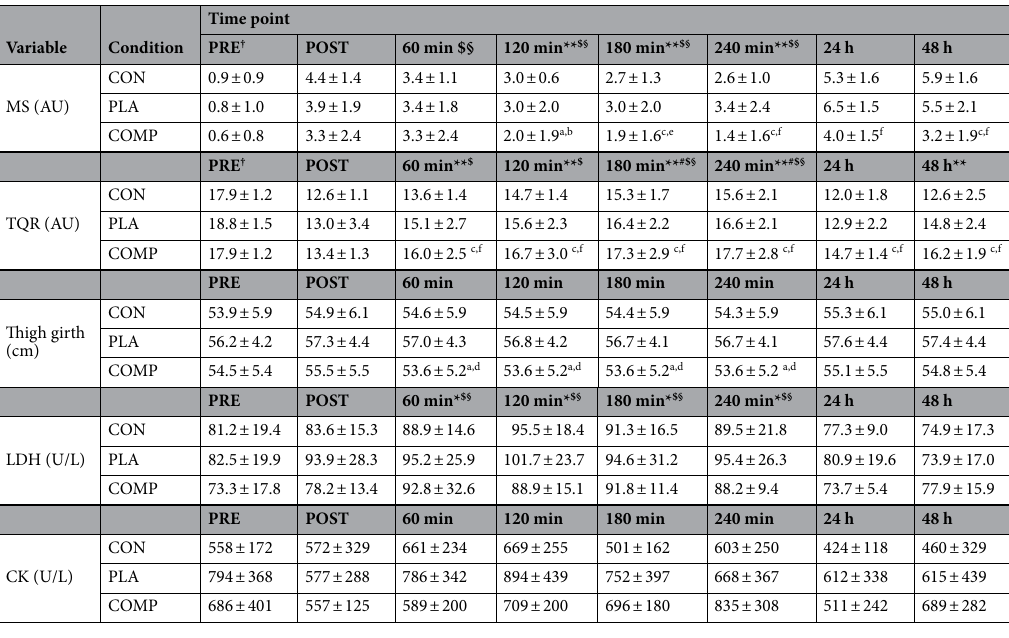
Table 5. Muscle soreness (MS), total quality of recovery (TQR), thigh girth, lactate dehydrogenase (LDH) and creatine kinase (CK) for CON, PLA and COMP conditions. Time points are before exercise (PRE), immediately post-exercise (POST), 4 h recovery (60–240 min), and 24 and 48 h post-exercise. All data presented as mean ± SD. † Significant time effect as compared with all other time points. *Significant time effect as compared with PRE. **significant time effect as compared with POST. # Significant time effect as compared with 60 min. $ Significant time effect as compared with 24 h. § Significant time effect as compared with 48 h. a Small effect as compared with CON. b Medium effect as compared with CON. c Large effect as compared with CON. d Small effect as compared with PLA. e Medium effect as compared with PLA. f Large effect as compared with